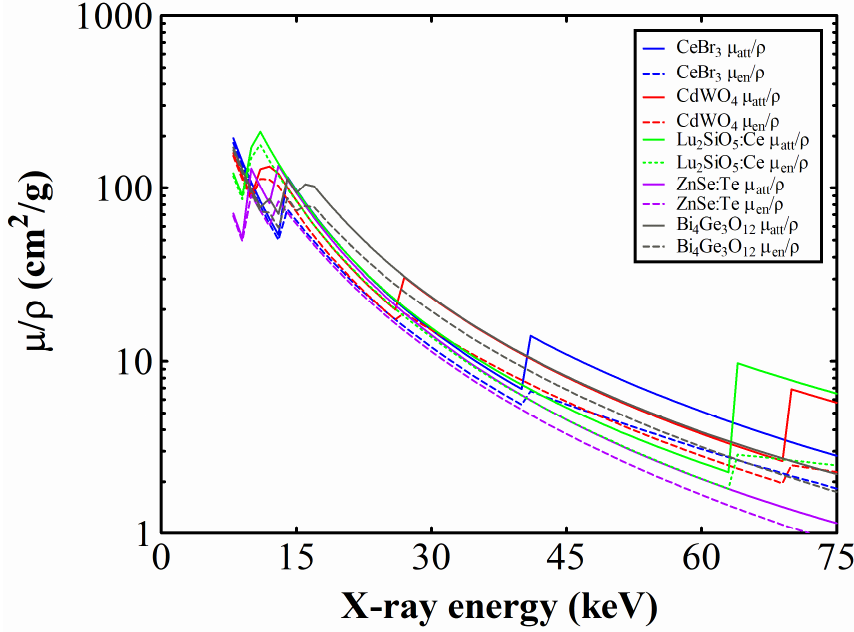
Figure 8. Compounds’ attenuation coefficients.